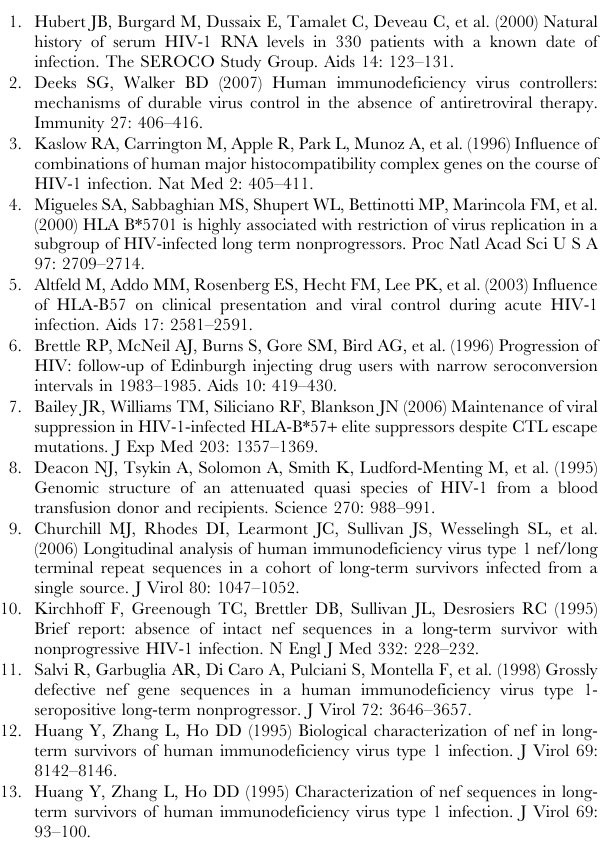
Figure S2 Affinofile cells allow for the analysis of both CD4 and CCR5. Figure S3 Full surface plots for chronic progressor (CP) and elite suppressor (ES) envelopes. (A–O) Surface plots are arranged by patient, including Yu-2 and SF-162 control strains, indicated in blue. CP envs are indicated in grayscale, and ES envs are indicated in red. Figure S4 Affinofile cells induced to express physiologic levels of CD4 and CCR5 express similar surface levels as CD4 +